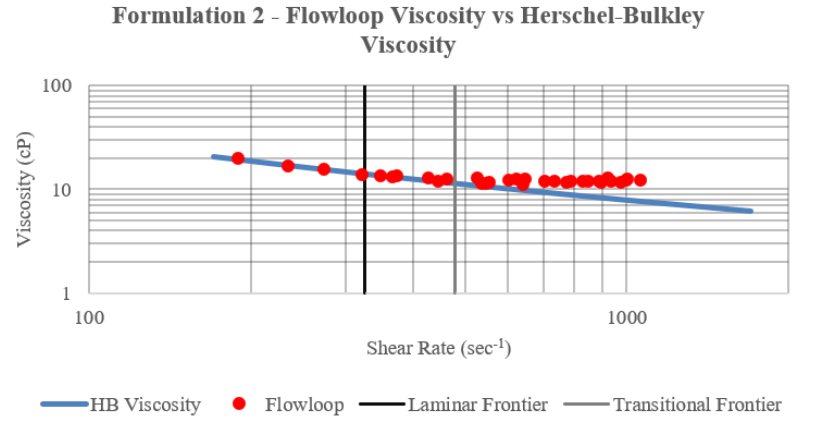
Figure 12: Formulation 2 - Flowloop Viscosity vs Herschel-Bulkley Viscosity